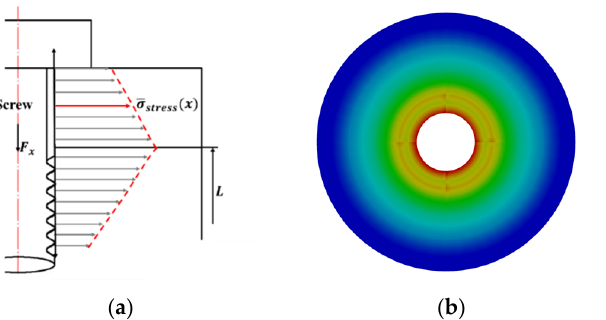
Figure 2. ( a ) Thread structure stress distribution diagram, ( b ) arbitrary cross-section stress distribu- tion diagram.